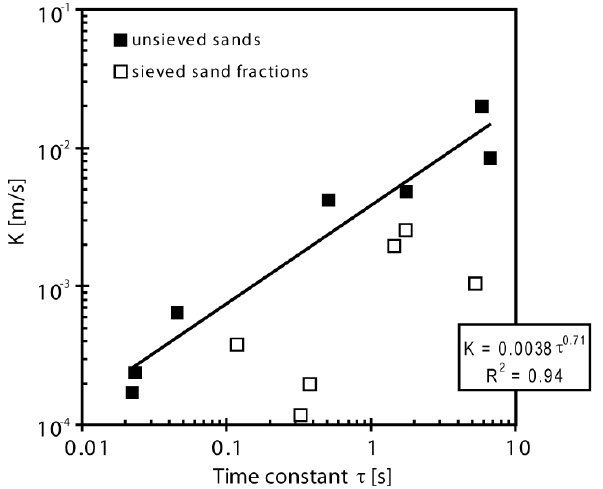
Fig. 6. Plot of the saturated hydraulic conductivity K versus Cole- Cole relaxation time τ for sieved and unsieved samples using a con- ductivity of ∼ 300µS/cm for the saturating pore water. In both cases the samples were compacted. The power law fit refers only to the data from unsieved sands, which is displayed as black full squares. Fig. 7. Plot of the saturated hydraulic conductivity K versus Cole-